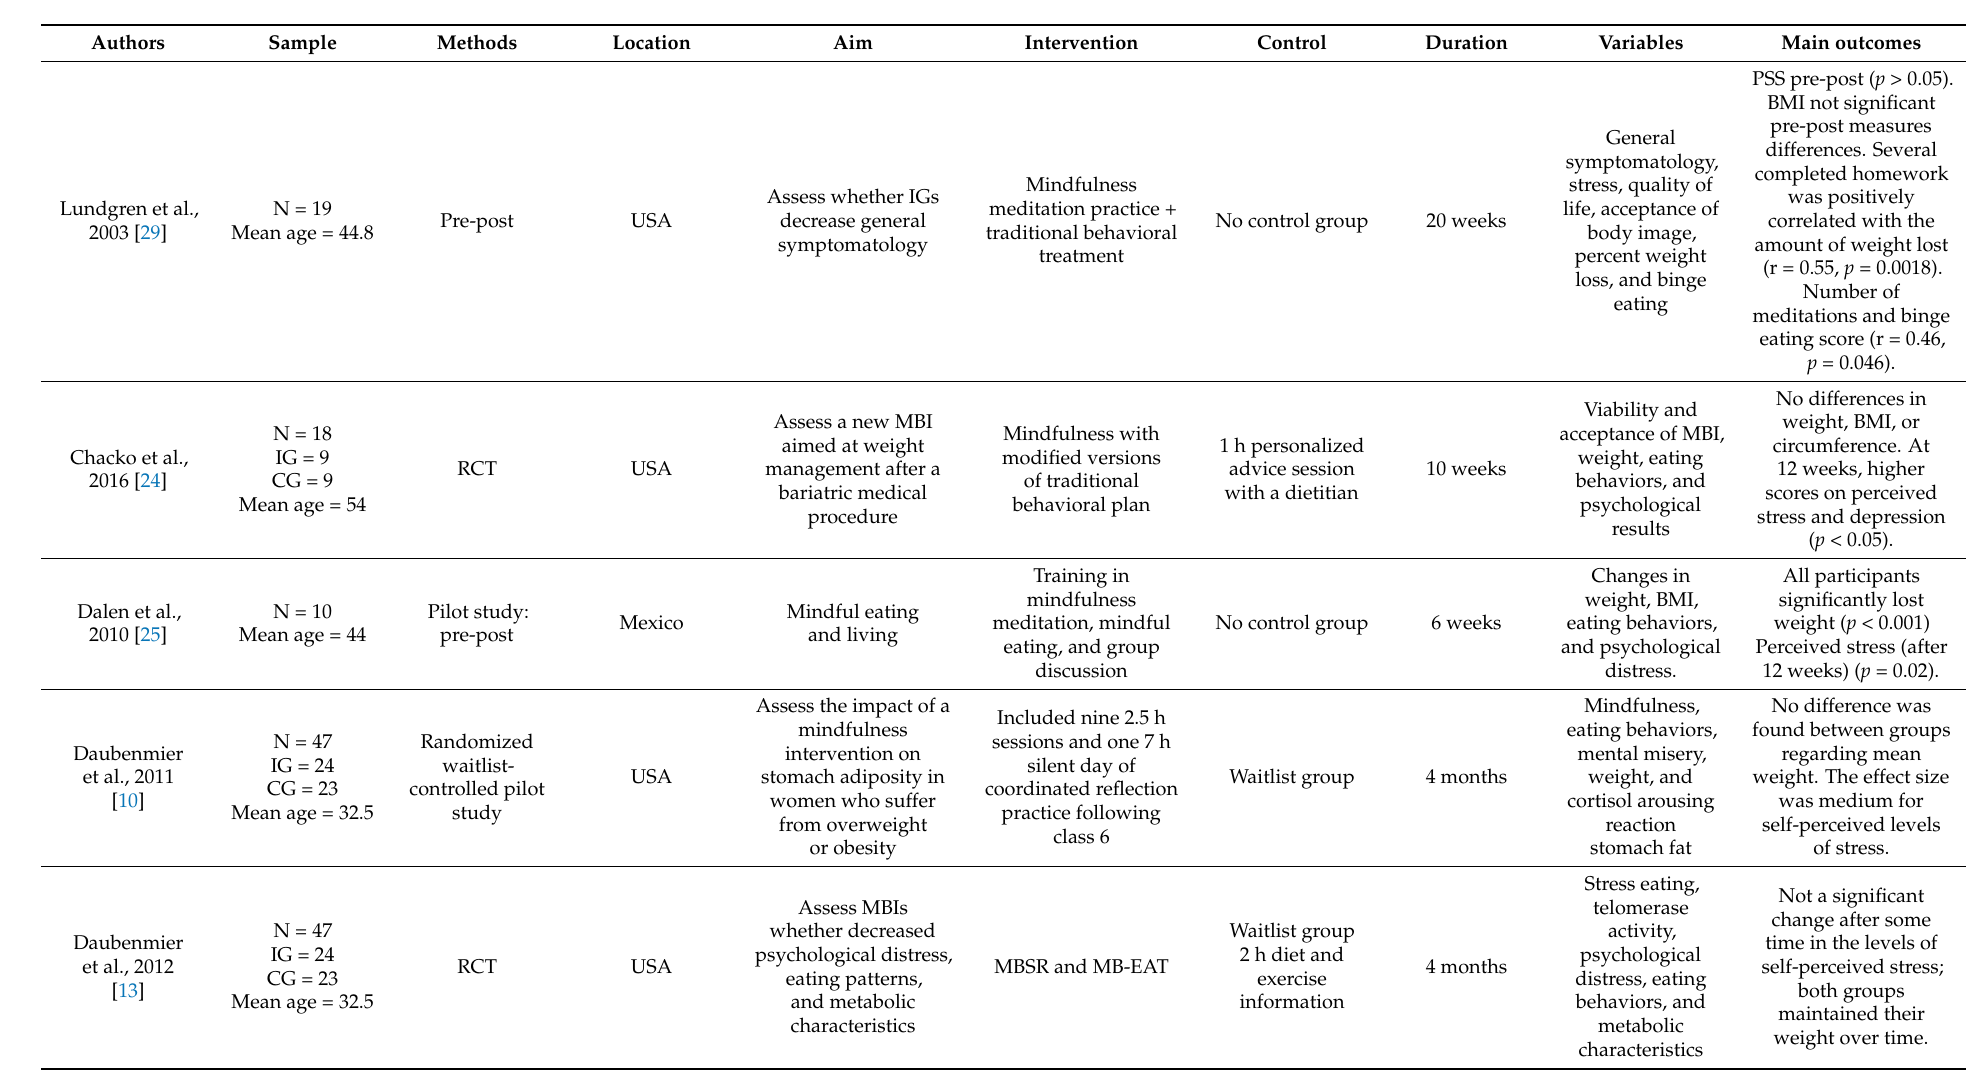
Table 1. Characteristics of the included